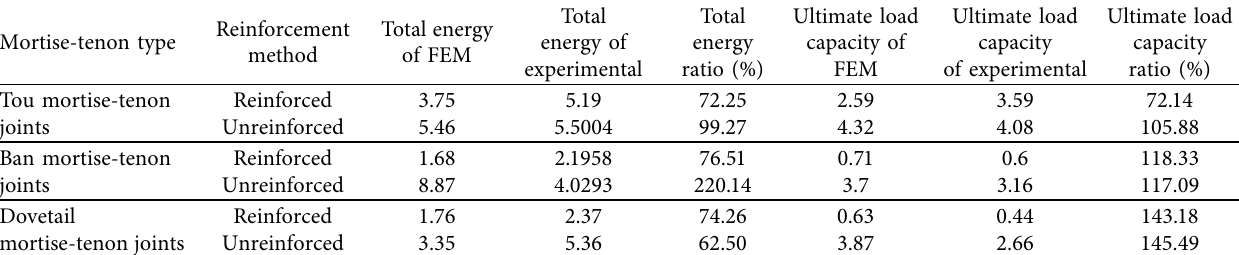
Table 10: Comparison of FEM and experimental results.